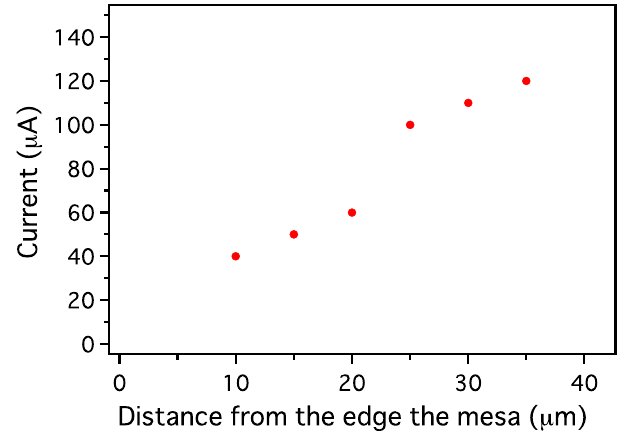
7. Distance dependence of the charge-state change in current from NV − to NV 0 .